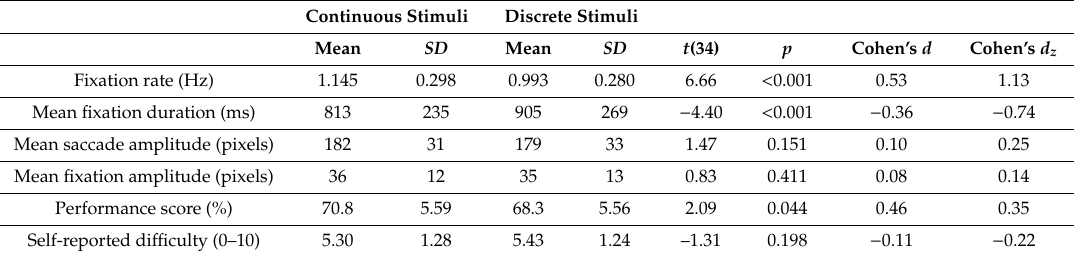
Table 2. Means and standard deviations ( SD ) of the dependent variables for continuous and discrete stimuli, as well as results of paired t -tests between the scores for continuous and discrete stimuli. Continuous Stimuli Discrete Stimuli